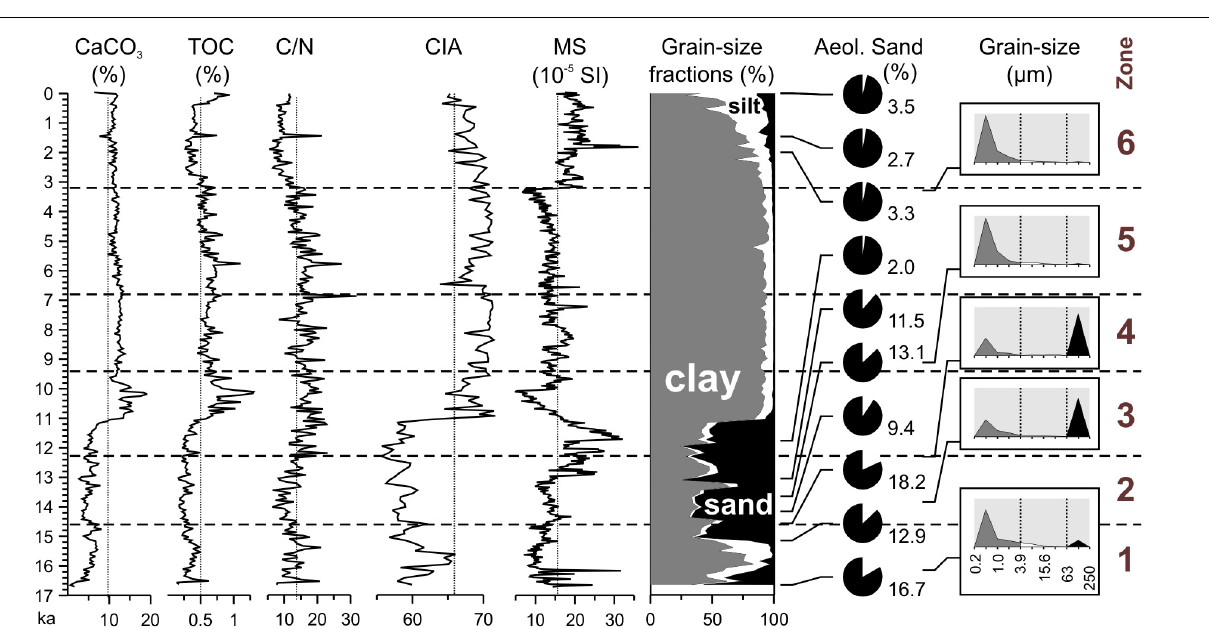
time. Thus, the MS data are not easily interpreted as a proxy of a single controlling